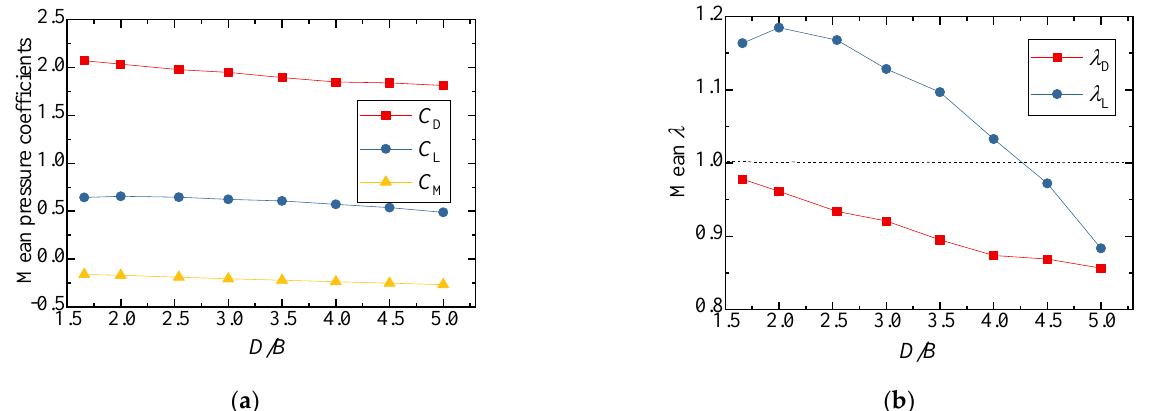
Figure 15. Comparison of the vehicle’s ( a ) aerodynamic coefficients and ( b ) interference factor for the various D/B ratios investigated in Case 3.